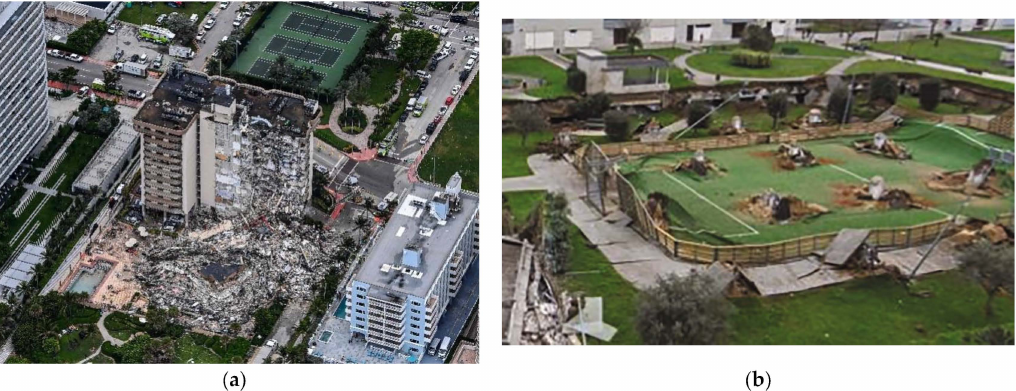
Figure 1. Collapsed of ( a ) condominium building [1] and ( b ) a parking garage on a playground